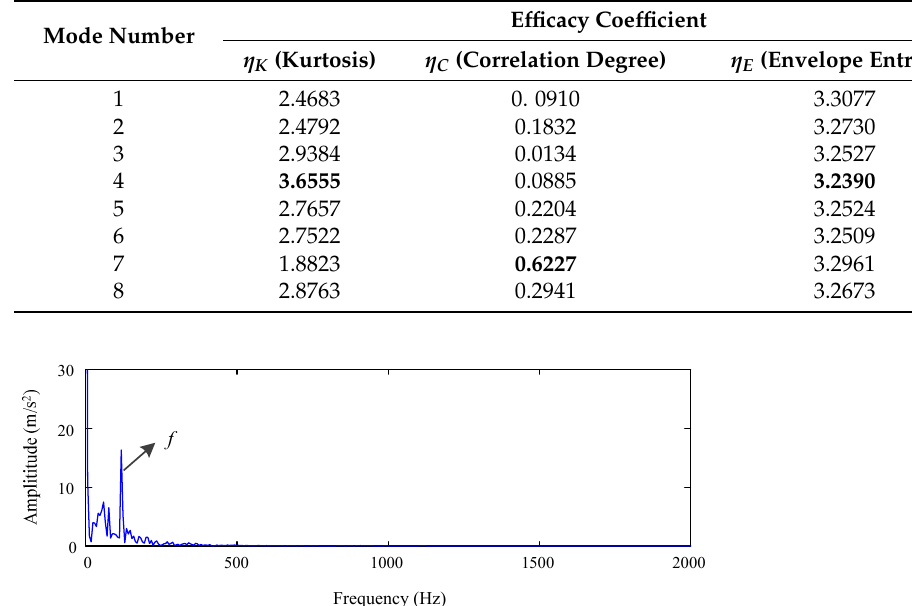
Table 3. Efficacy coefficients corresponding to Decomposed Mode components to the challenging signal.